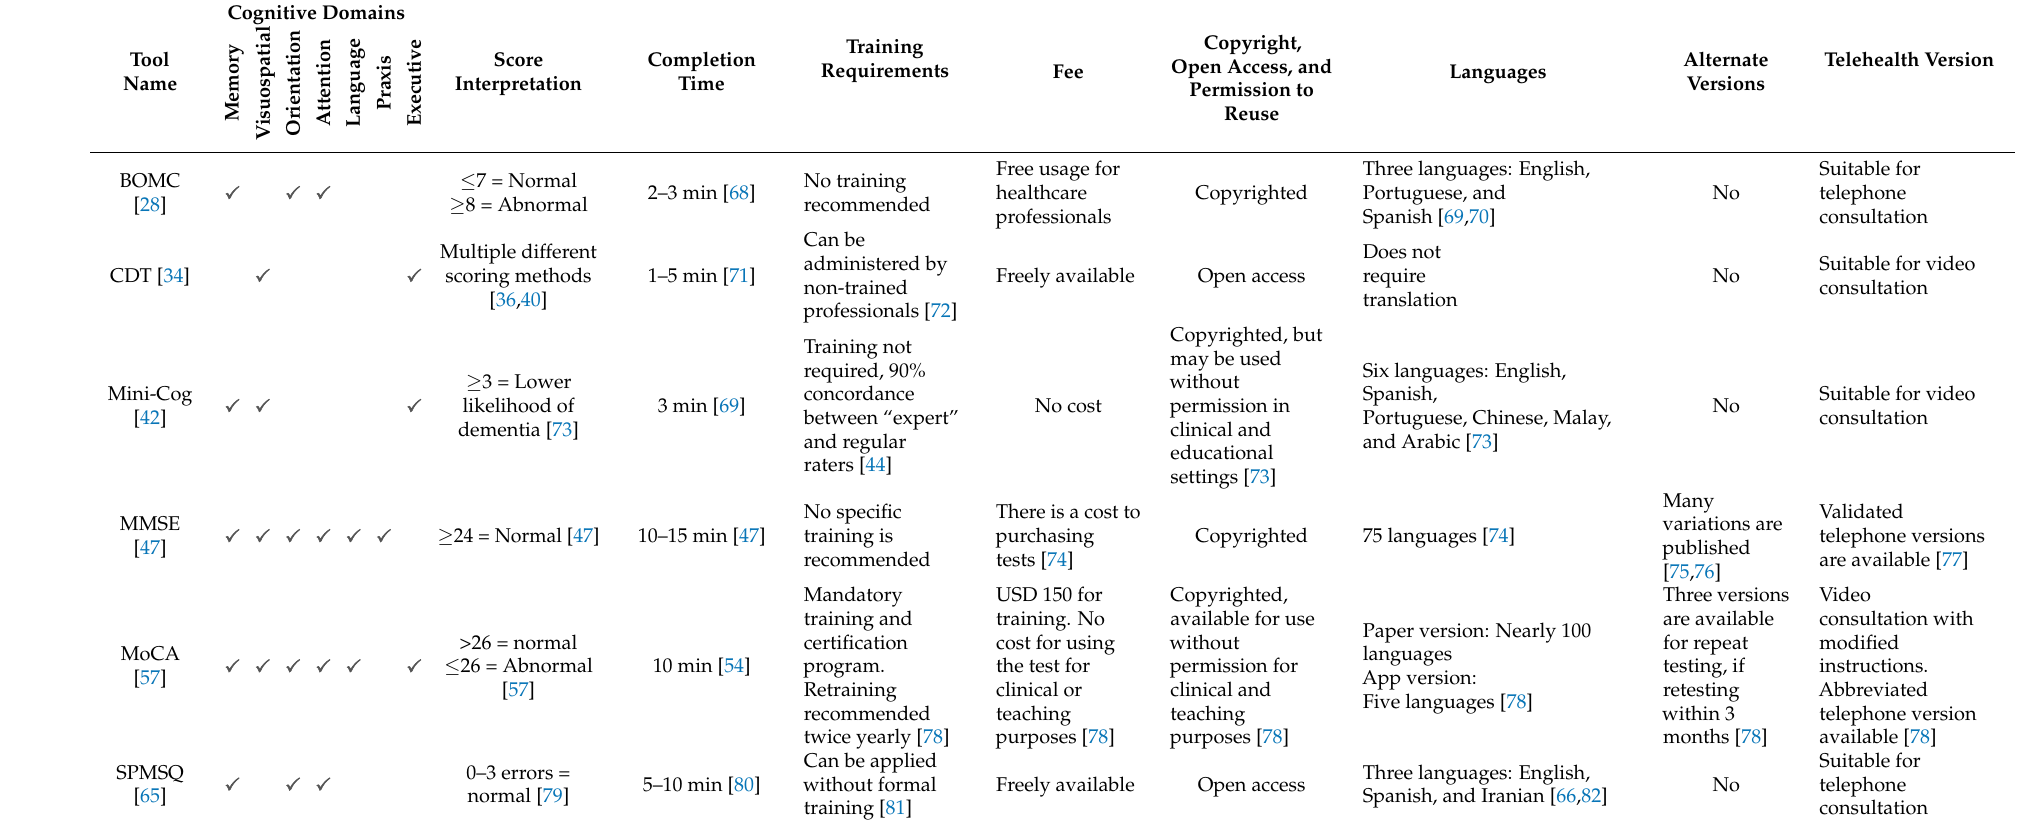
Table 5. Practical considerations for clinical use.